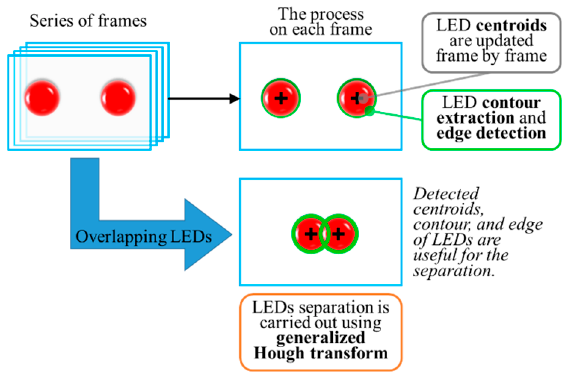
Figure 28. Detection algorithm for overlapping LEDs [92].